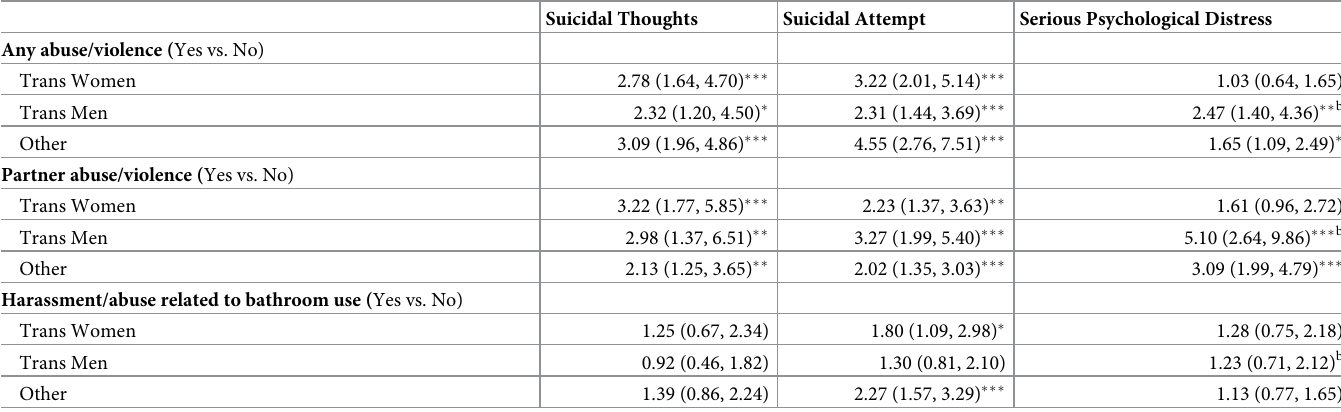
Table 5. Adjusted odds ratio (OR) and 95% confidence interval (CI) of mental health outcomes a by gender identity group (weighted sample =